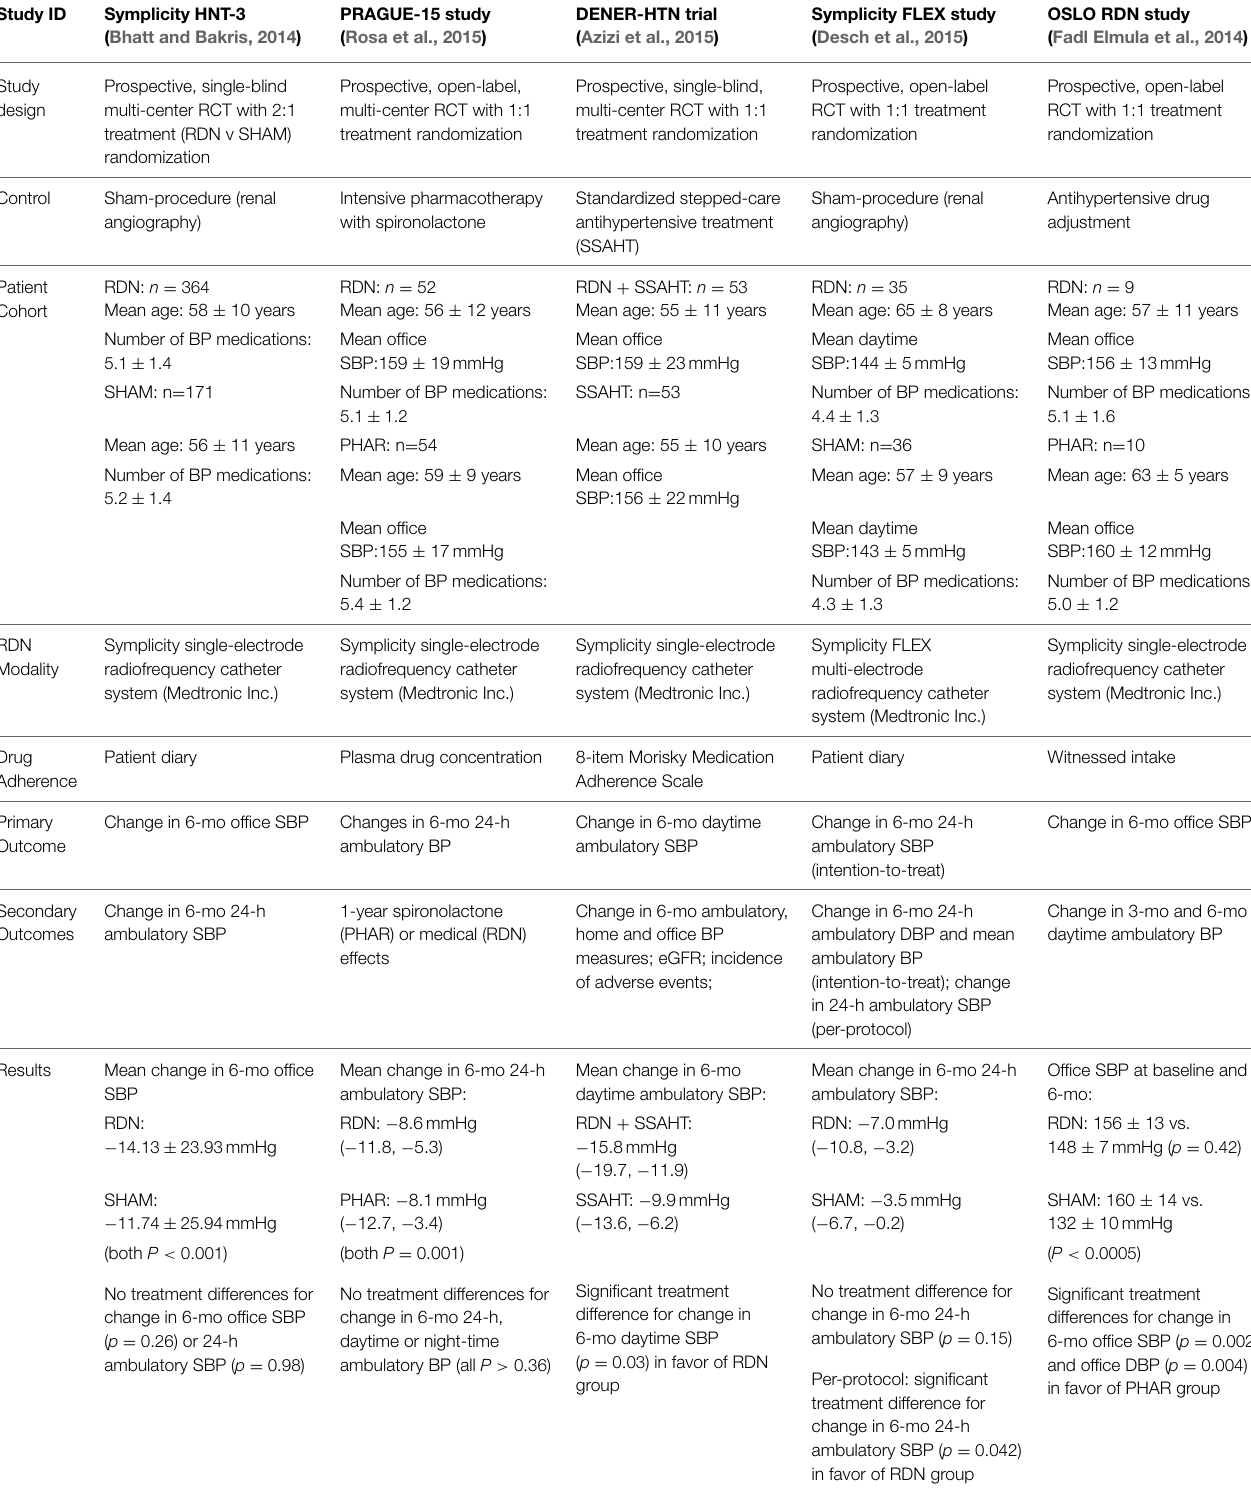
TABLE 2 | Randomised controlled trials using renal nerve ablation in the treatment of resistant hypertension in the last 12-months. Study